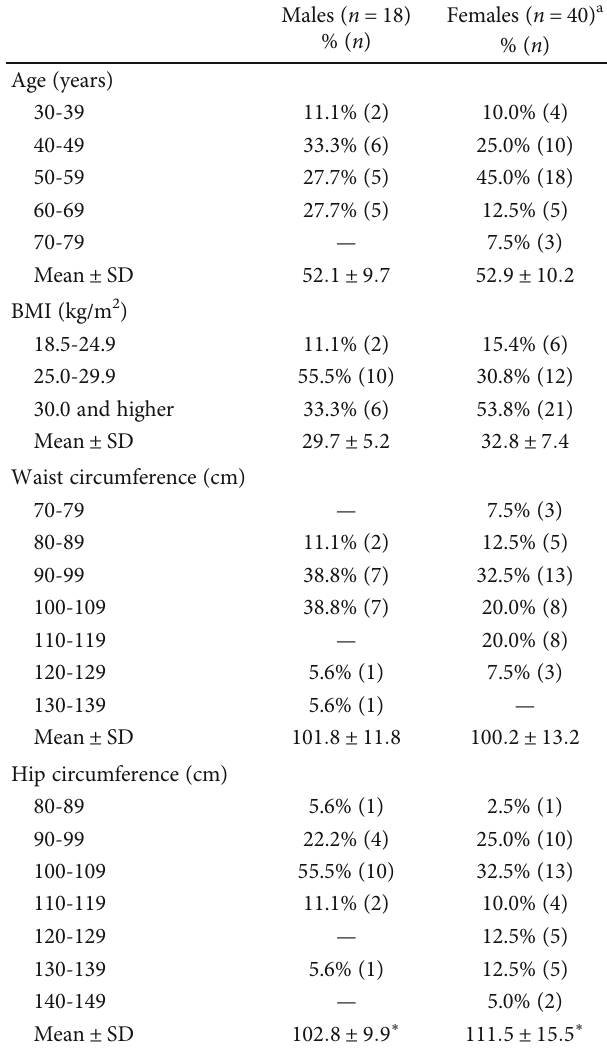
Table 1: Participant characteristics at baseline ( n = 58